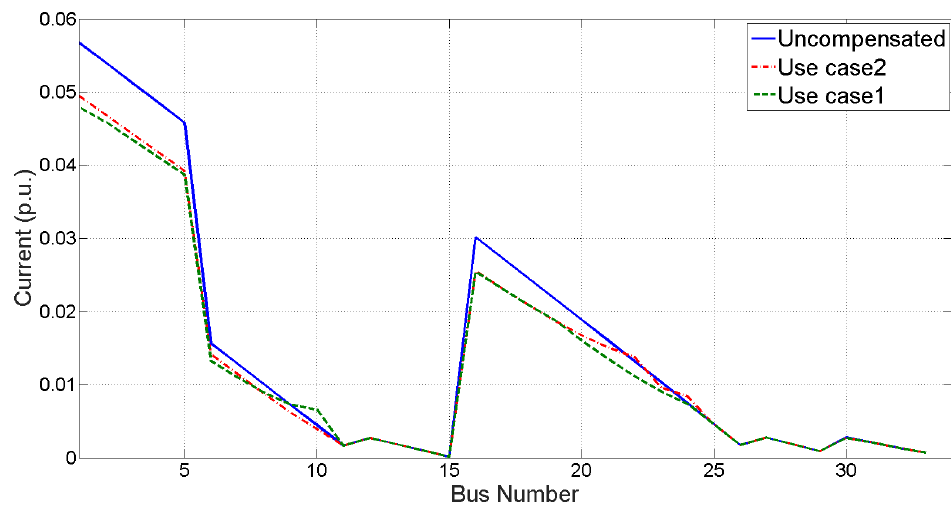
Figure 7. Line flow for N 1 in CS 1